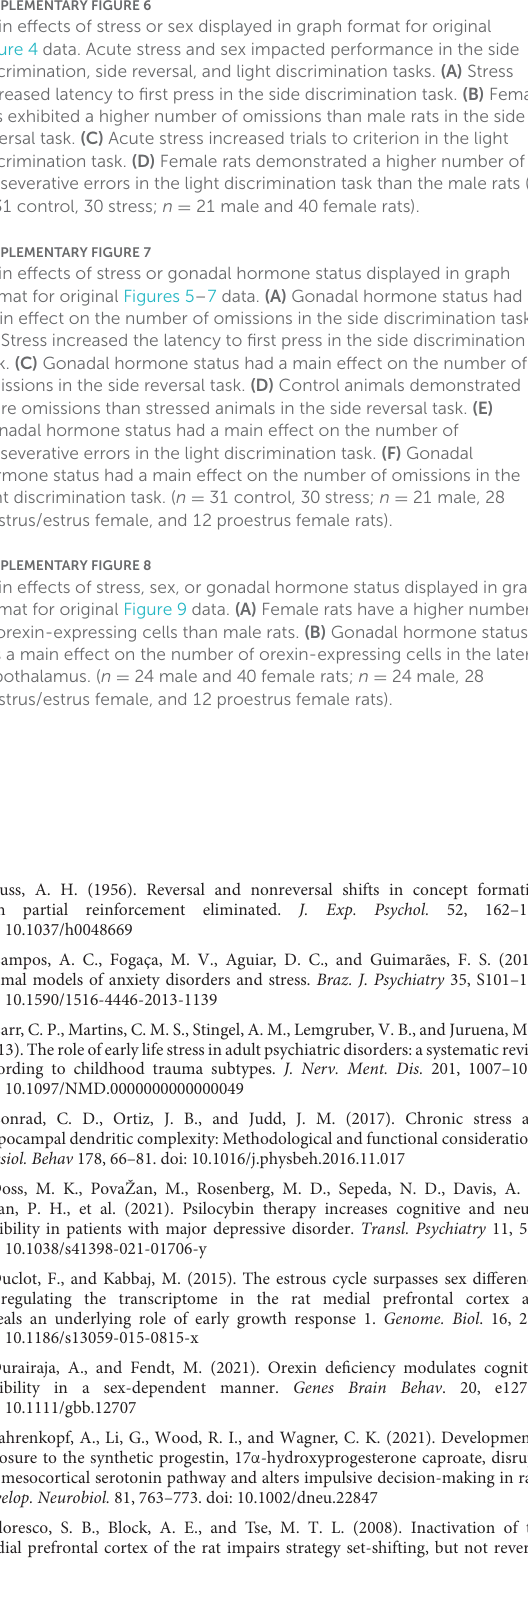
in the light discrimination task. Error bars are plotted as mean ± SEM. ∗ p < 0.05 and ∗∗ p < 0.01. SUPPLEMENTARYFIGURE6 Main effects of stress or sex displayed in graph format for original Figure 4 data. Acute stress and sex impacted performance in the side discrimination, side reversal, and light discrimination tasks. (A) Stress increased latency to first press in the side discrimination task. (B) Female rats exhibited a higher number of omissions than male rats in the side reversal task. (C) Acute stress increased trials to criterion in the light discrimination task. (D) Female rats demonstrated a higher number of perseverative errors in the light discrimination task than the male rats ( n = 31 control, 30 stress; n = 21 male and 40 female rats).